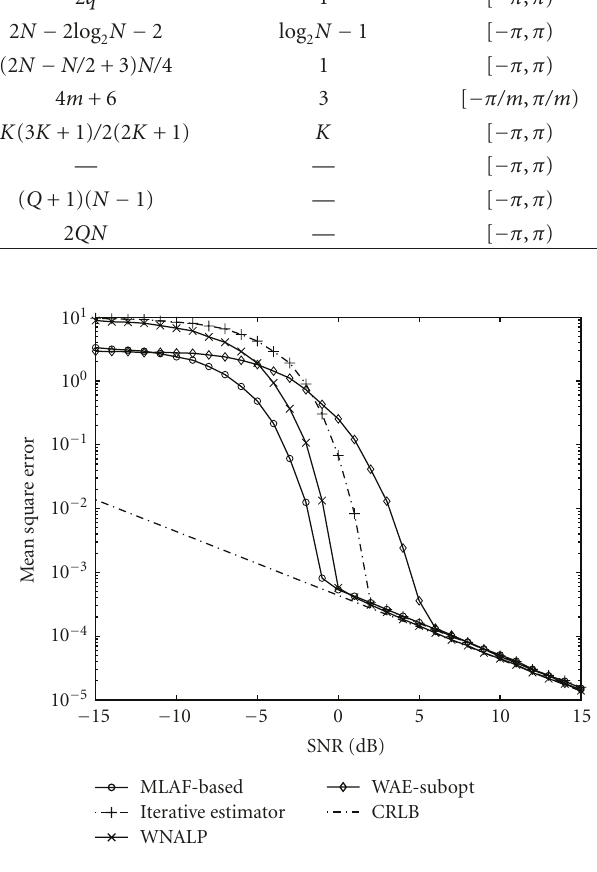
Figure 3: Comparison with other autocorrelation-based estima- tors. N = 24, ω = 0 . 8 π . For the MLAF-based estimator, q = 4 and τ =